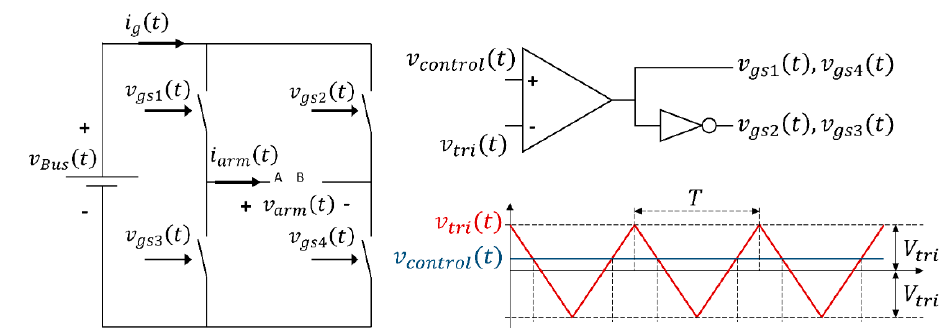
Figure 15. Motor drive and the pulse-width modulation.